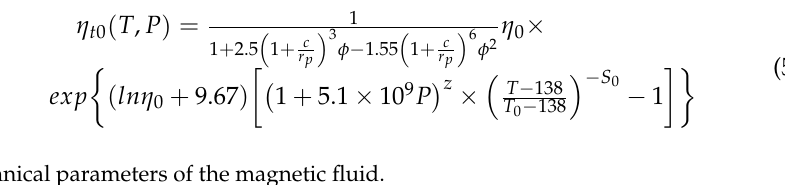
Table 3. Main technical parameters of the magnetic fluid.